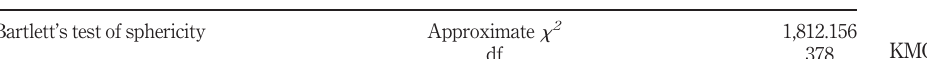
Table 2. KMO and Bartlett ’